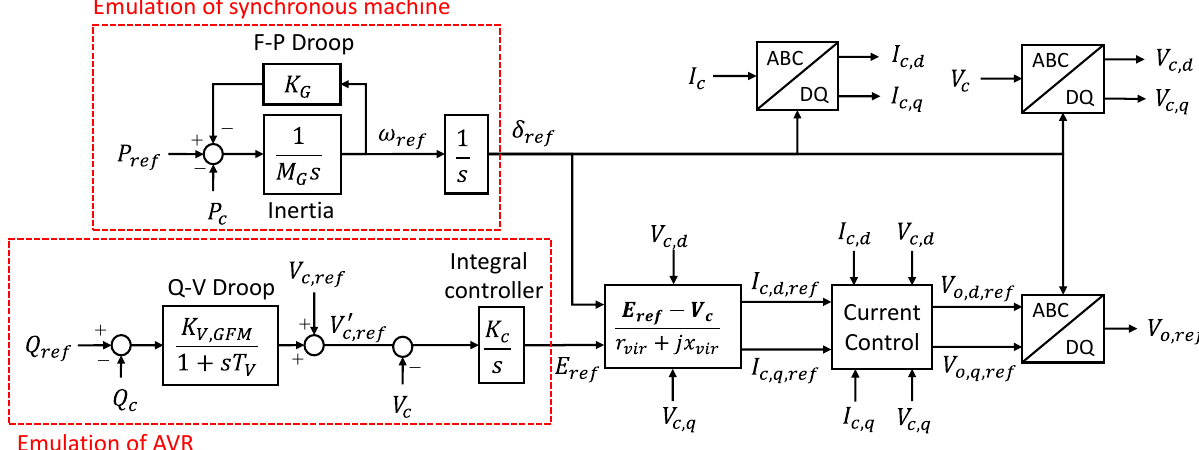
Figure 2. Block diagram of controller of VI-GFM.